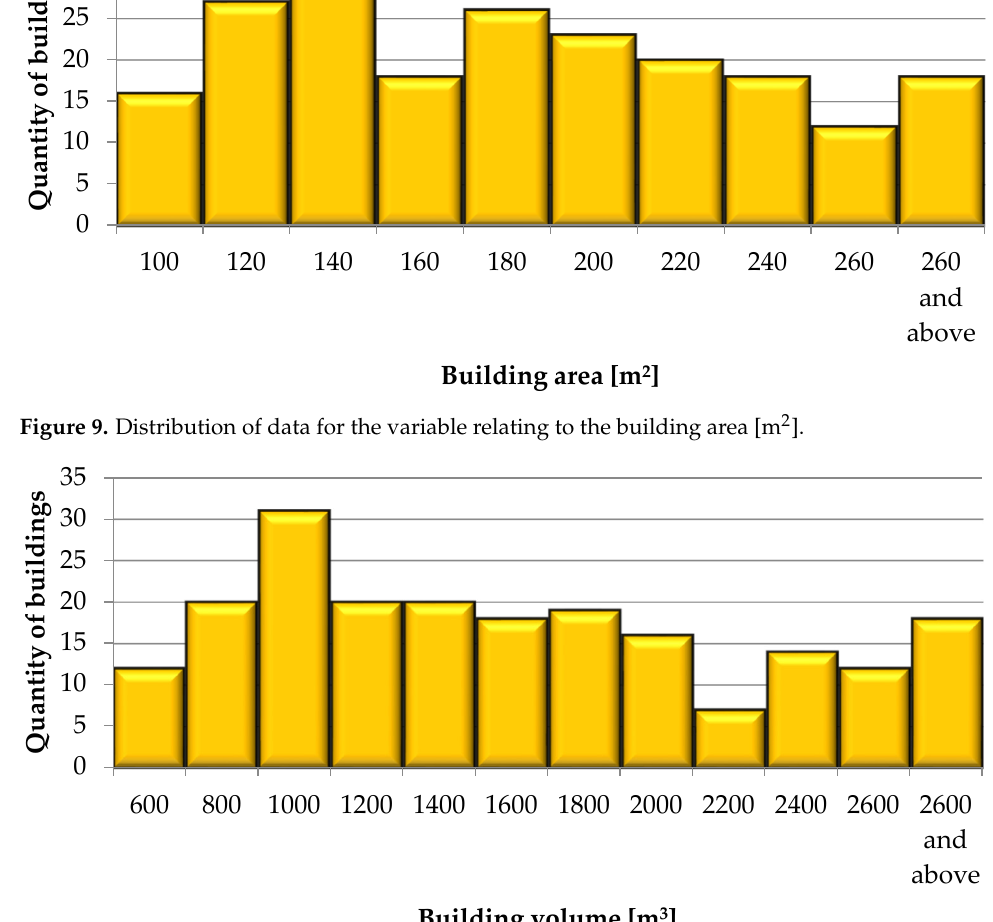
Figure 10. Distribution of data for the variable relating to the building volume [m 3 ].